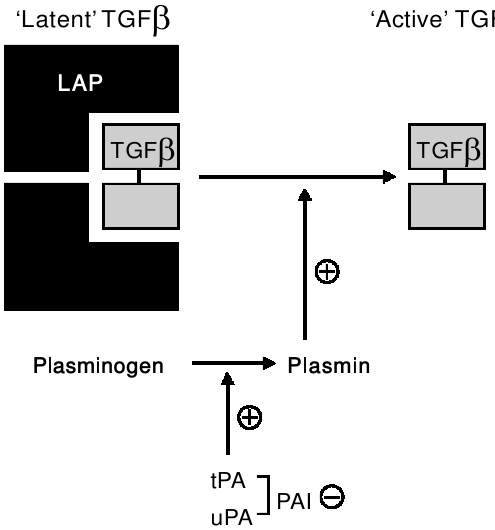
FIG. 6. Activation mechanism of latent TGF b by plasmin. Plasmin releases TGF b from its latency associated protein (LAP) whereby active TGF b is generated. Plasminogen is cleaved into plasmin by plasminogen activators i.e. uroki- nase PA (uPA) or tissue-type PA (tPA) which are inhibited by plasminogen activators inhibitors